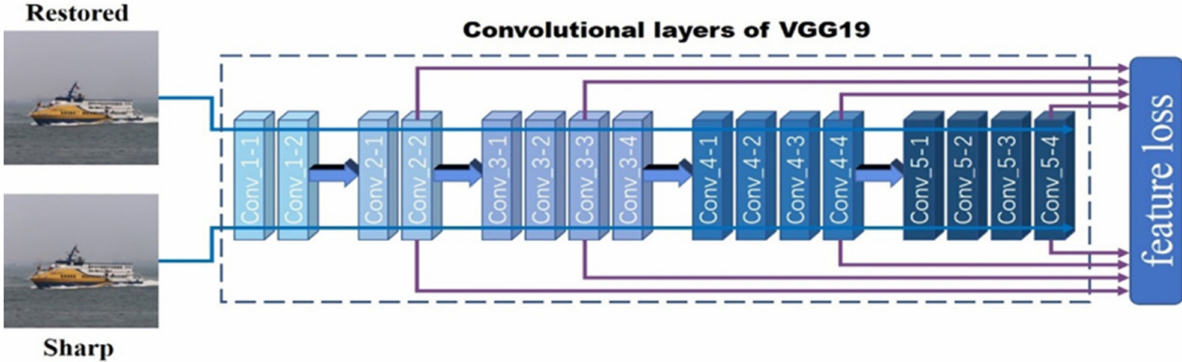
Figure 3. The feature loss fuses the different layers of features extracted from the VGG19